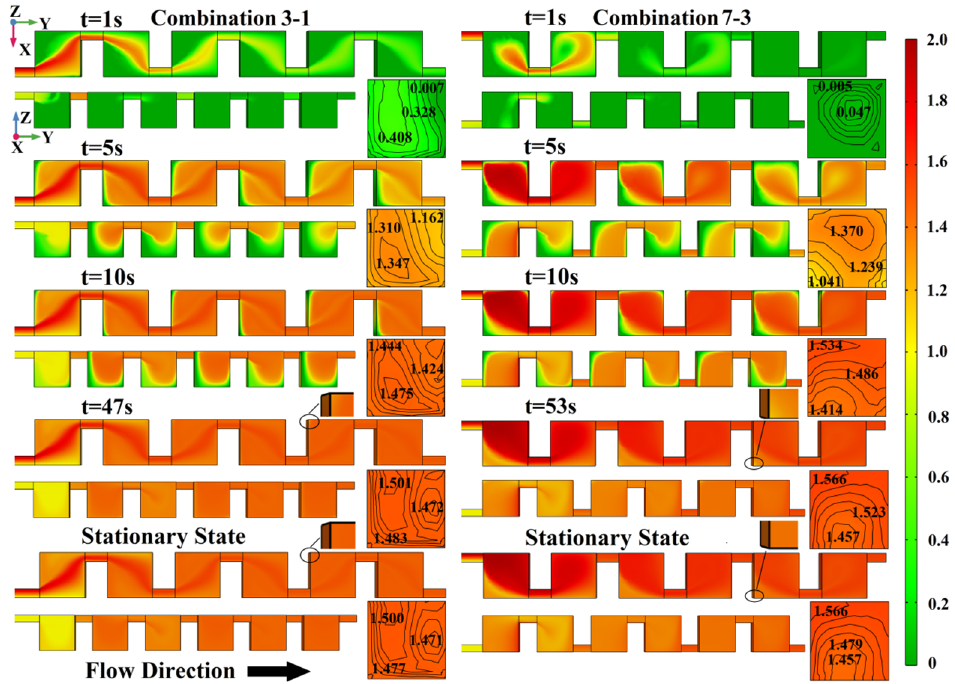
Figure 8. The surface and outlet concentration distributions of mixers with junction locations 3–1 and 7–3 at different time points.